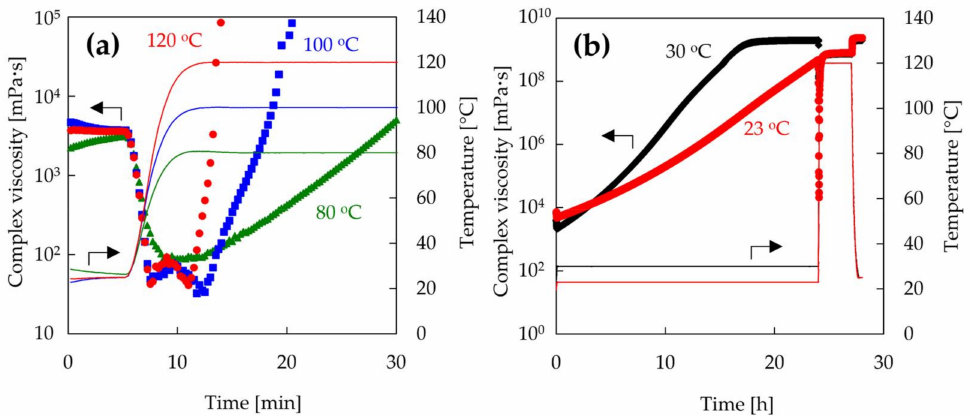
Figure 7. Complex viscosity of epoxy resin at different temperatures as a function of time. The epoxy resin was heated after mixing ( a ) or pre-curing ( b